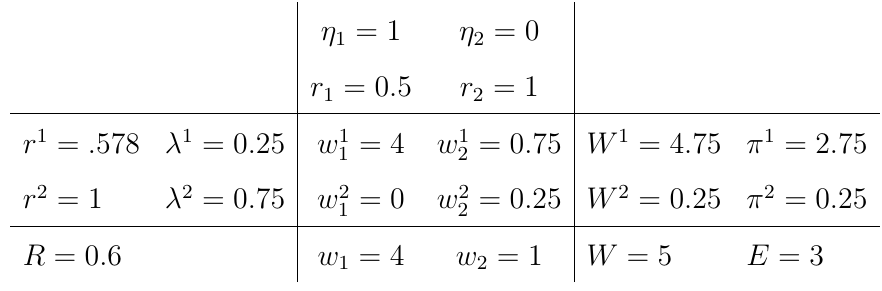
Table 2. Nash equilibrium in Example